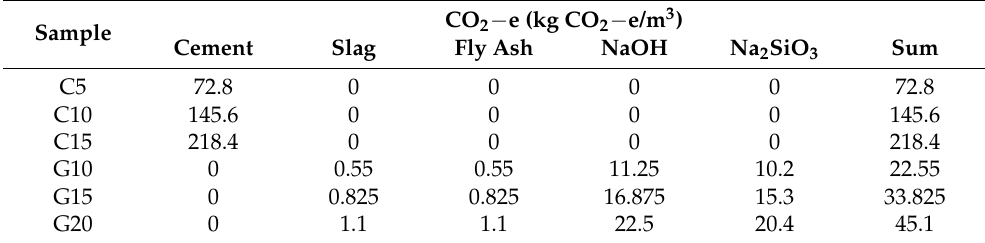
Table 9. Carbon emissions of cementing materials per cubic meter of stabilized aeolian